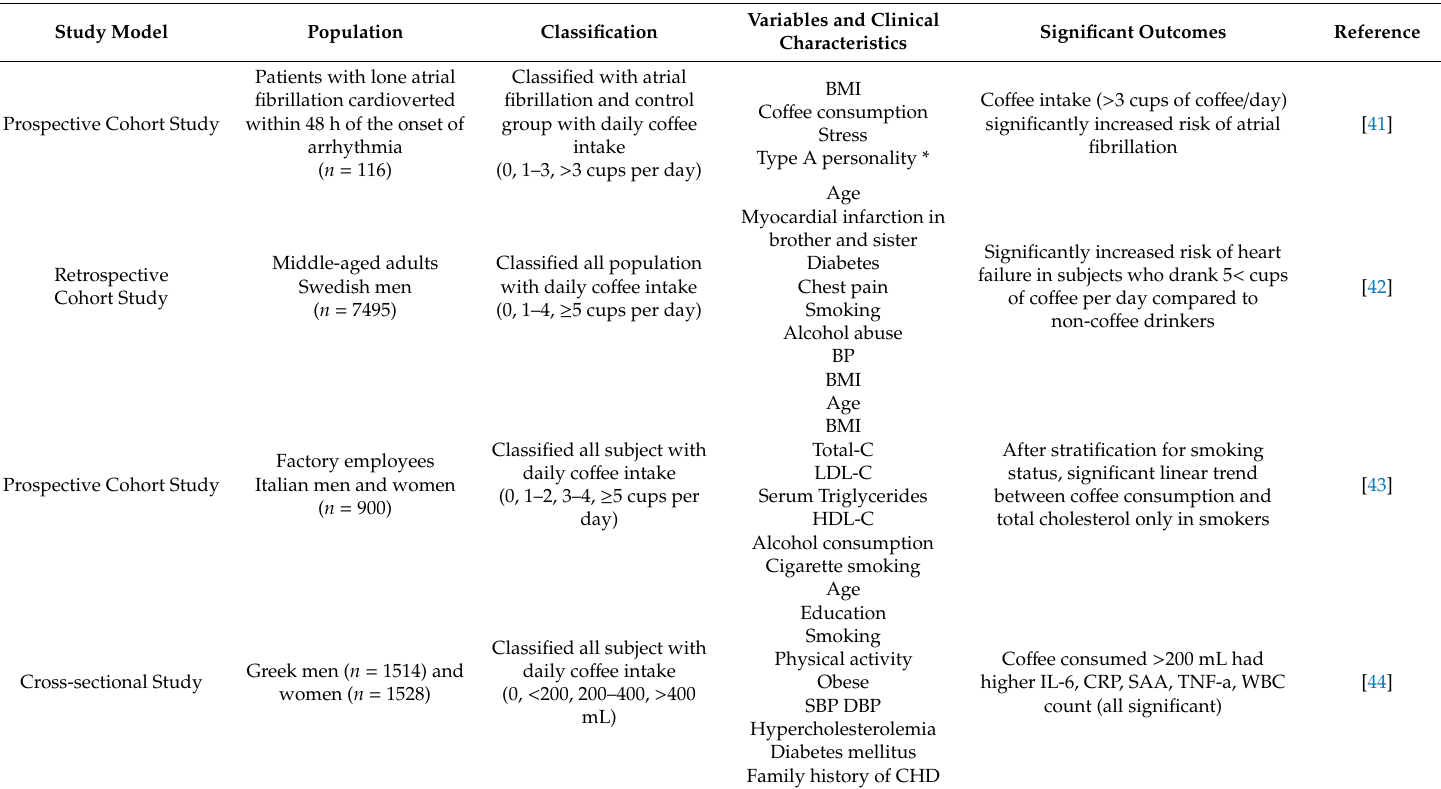
Table 3. Major parameters, clinical characteristics and outcomes from epidemiological studies investigating influence of co ff ee consumption on cardiovascular disease and its risk factors reviewed in this